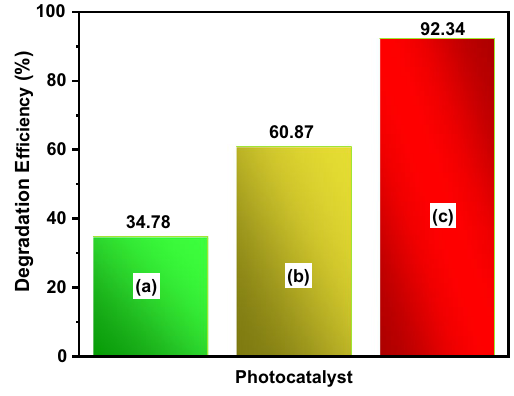
Fig. 9 Degradation efficiency of MB for (a) SnO SnO 2 NPs and (c) 4% Y-doped SnO 2 NPs